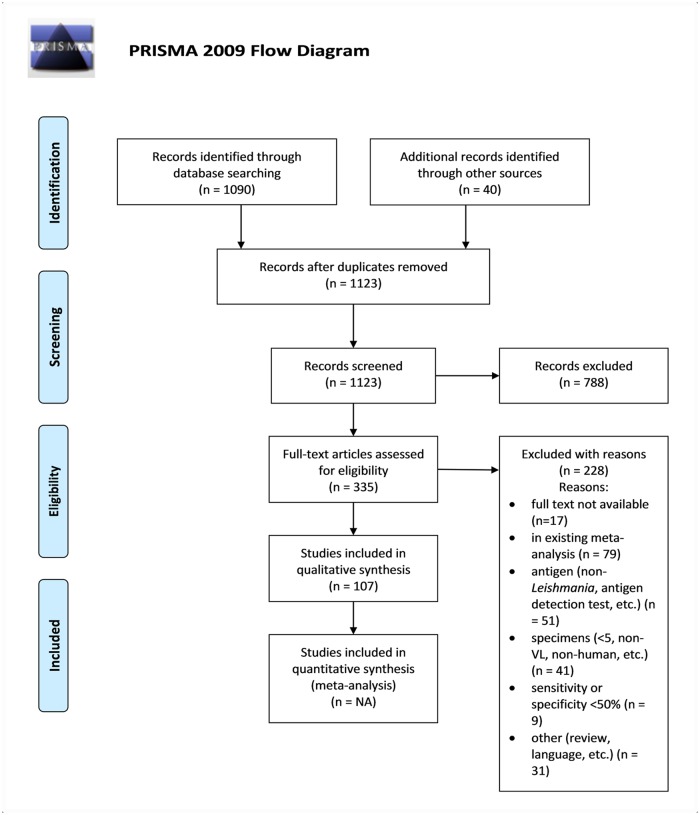
PRISMA 2009 flow diagram adapted from Moher et al. (2009) [20].